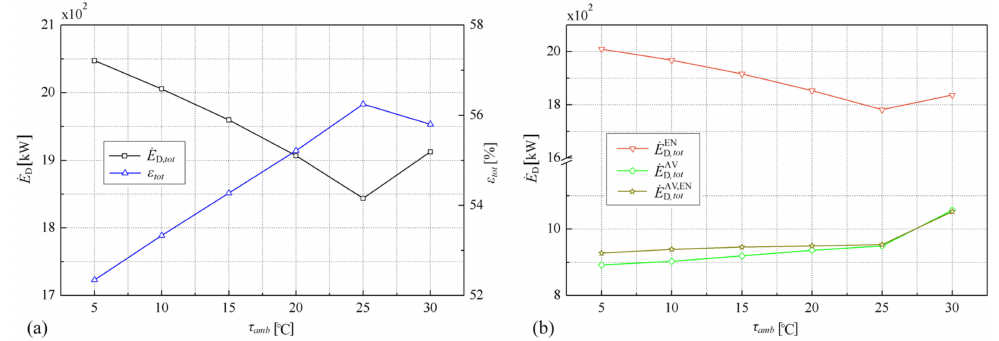
Figure 9. E ff ects of ambient temperature: ( a ) conventional exergy analysis results; ( b ) advanced exergy analysis